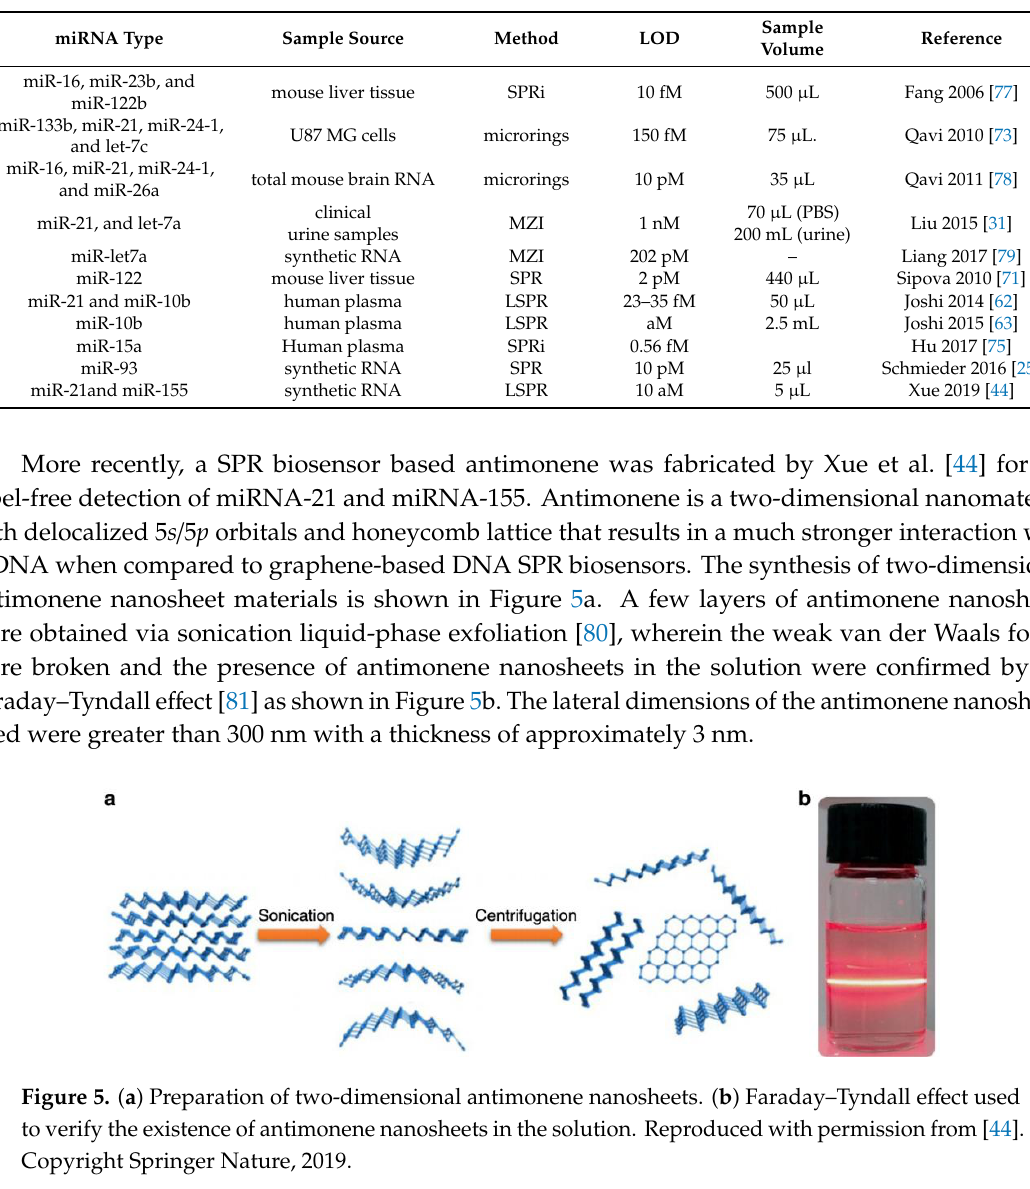
Table 1. Comparison of label-free microRNA optical sensors.